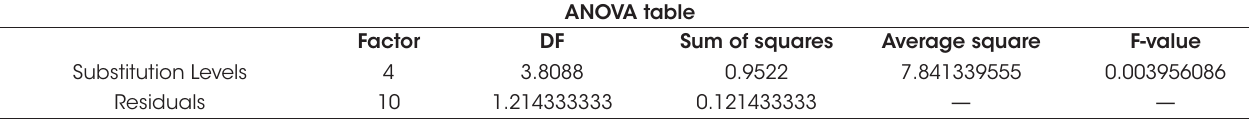
Analysis of variance results – p value – of absorption by immersion ANOVA table Factor DF Sum of squares Average square Substitution